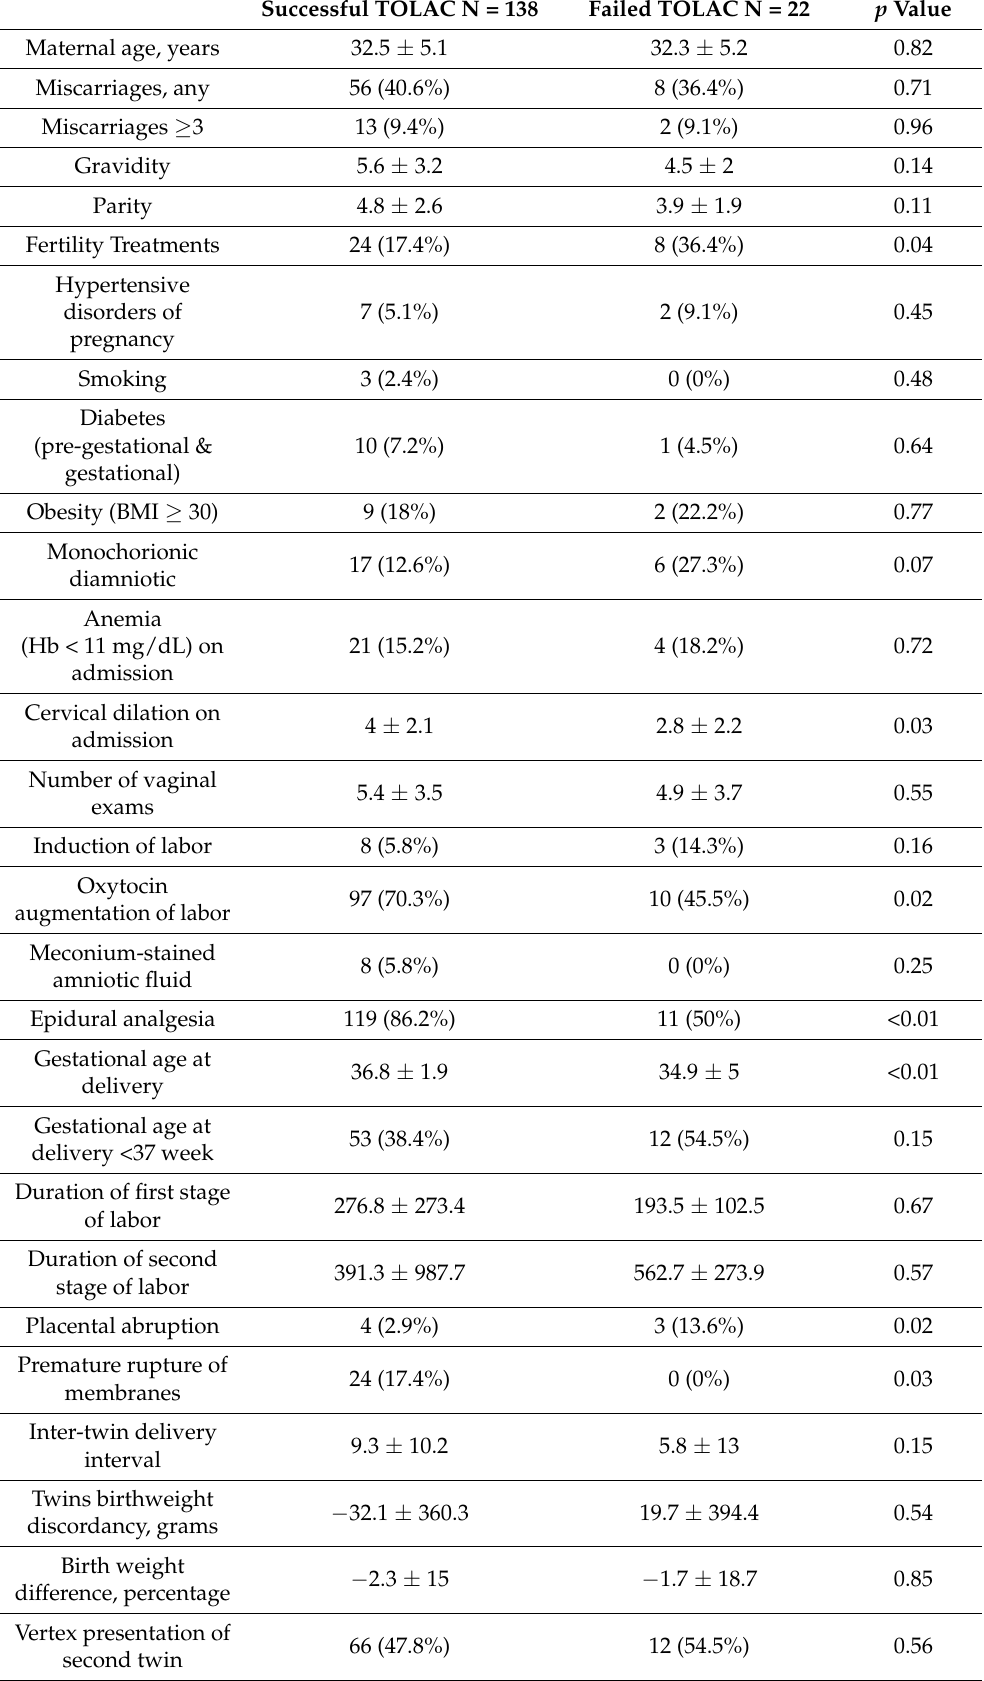
Table 1. Baseline and labor characteristics of the study